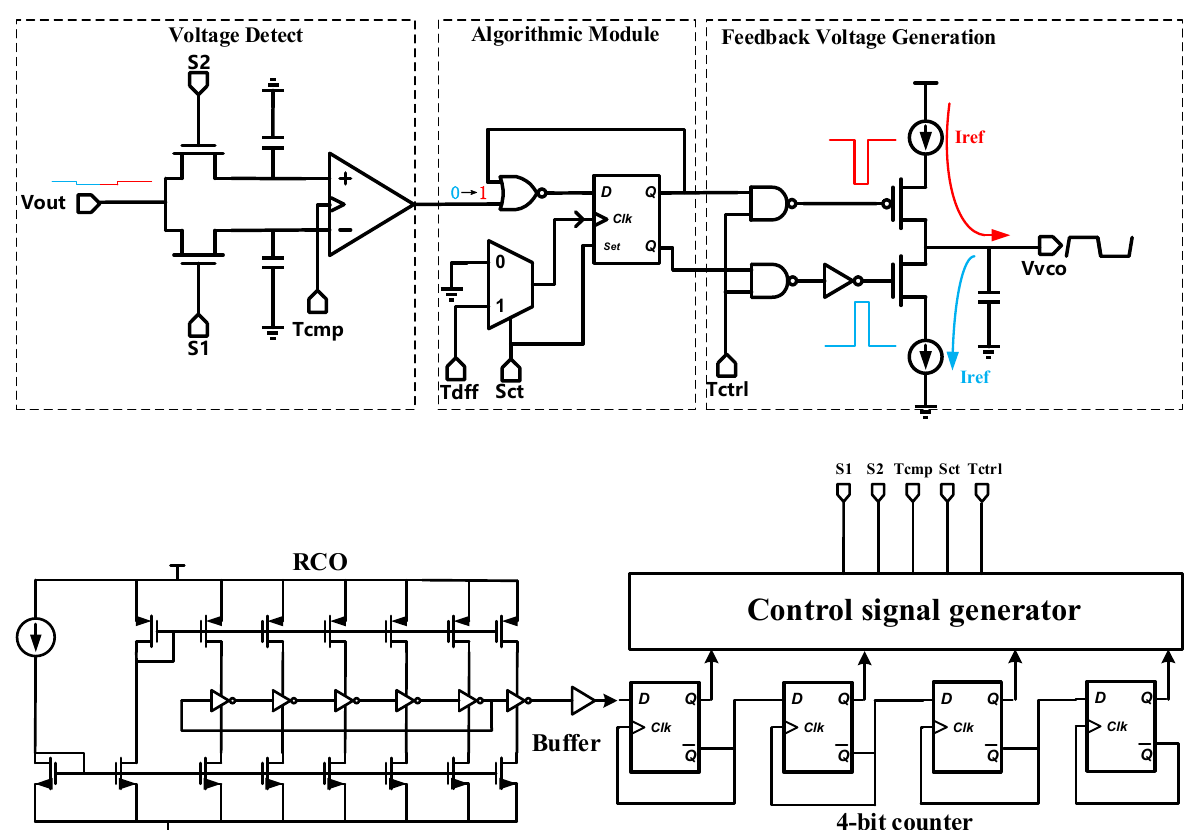
Figure 9. Schematic of MPPT control module and the control clock generation module.